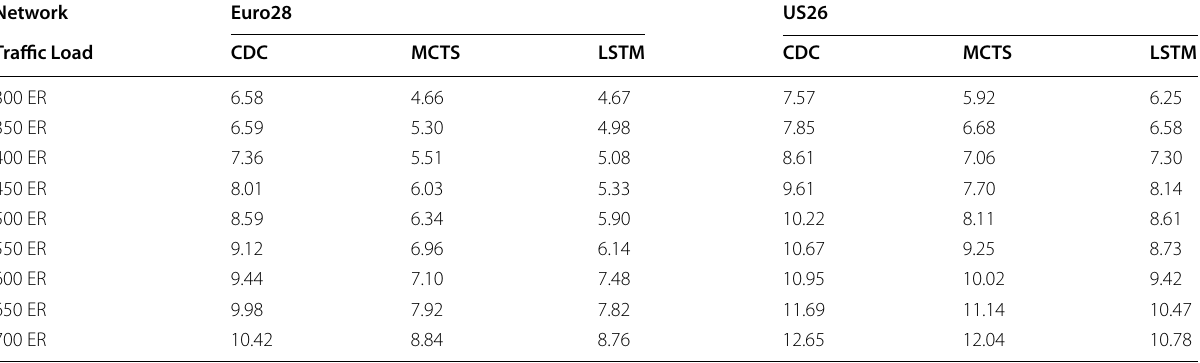
Table 4 Service cost per hour (in Usd), scenario #3